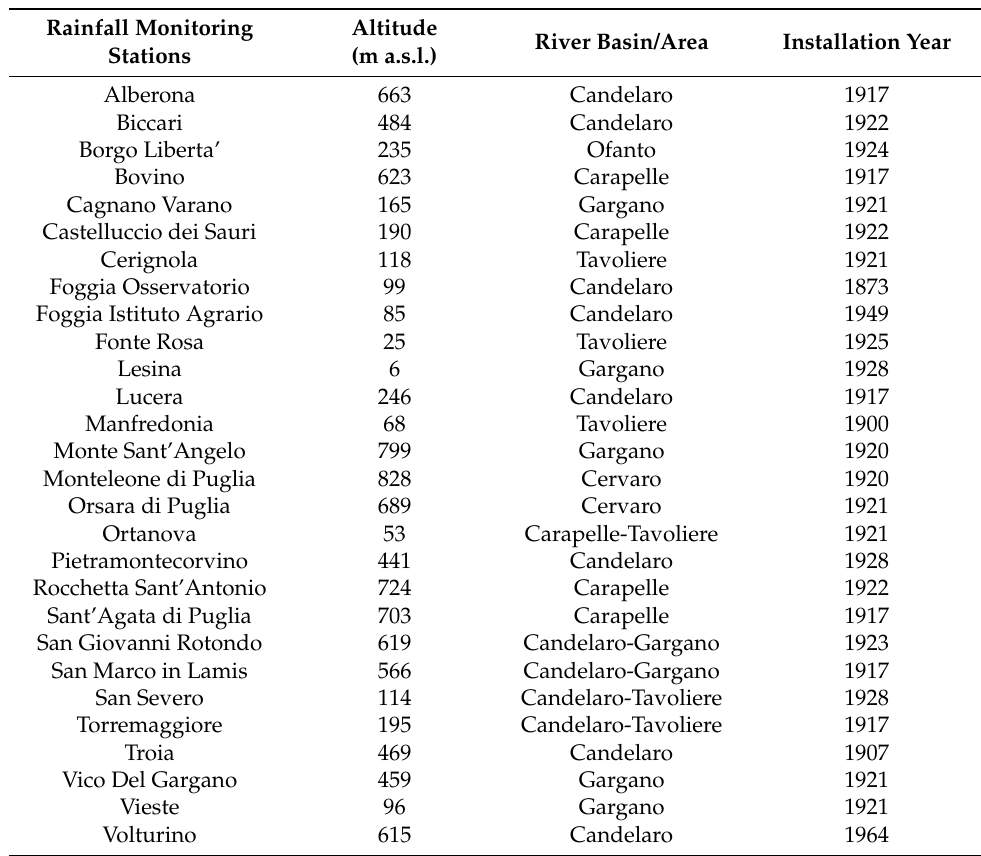
Table 1. Rainfall monitoring